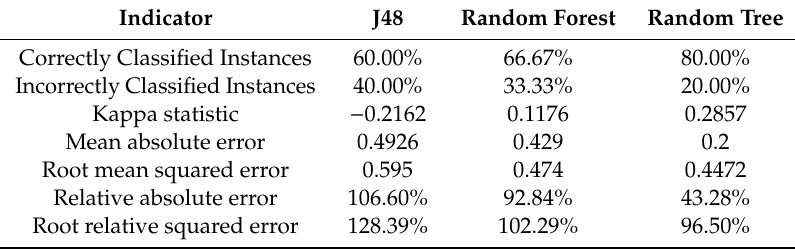
Table 6. Indicators to compare the models generated by the studied algorithms to predict R a ,0